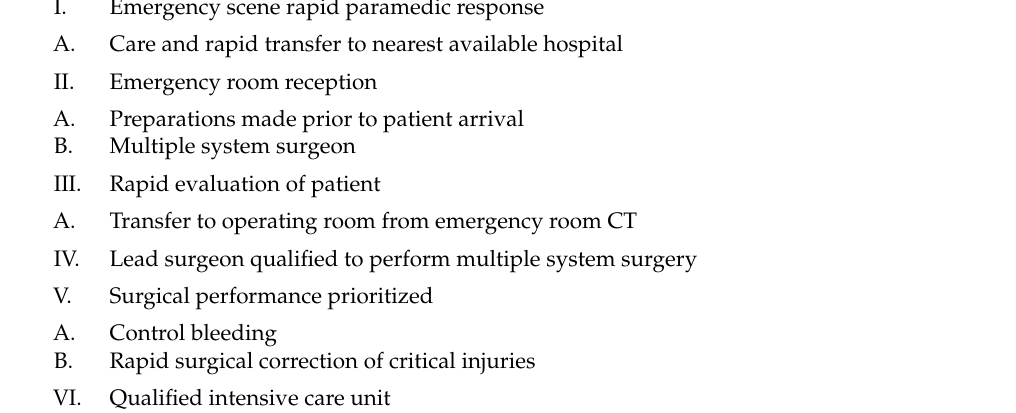
Table 3. Flow Chart For Major Injury